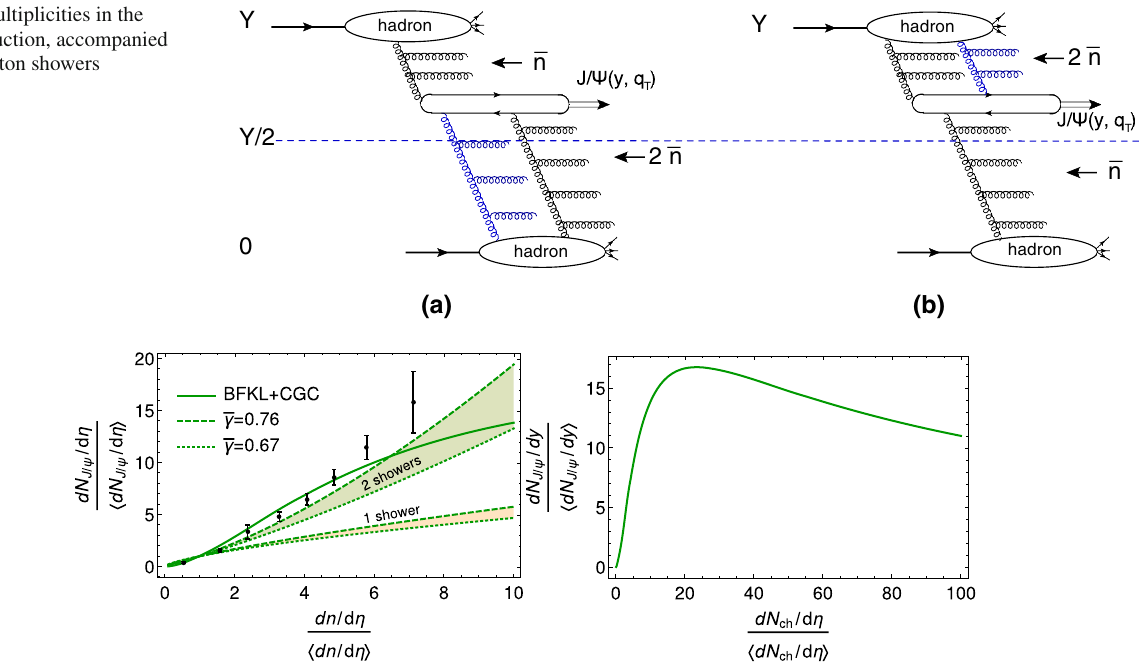
Fig. 7 Left plot: comparison of the multiplicity distribution with the experiment [22]. Solid line: result of evaluations with (9) using CGC parameterization for the dipole amplitude and saturation scale adjusted according to (38). The upper band marked “2-showers” stands for the estimates with approximate expression (39) and values of ¯ γ varied in the range ¯ γ ∈ ( 0 . 67 , 0 . 76 ) , as implemented in phenomenological